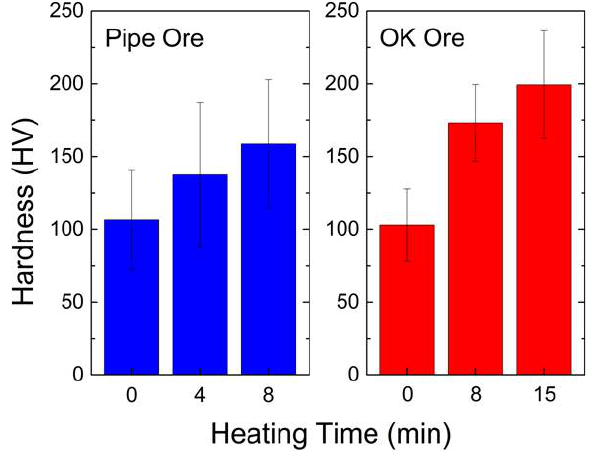
Figure 10. Micro-hardness results for untreated and microwave pretreated Pipe and OK ores [48].